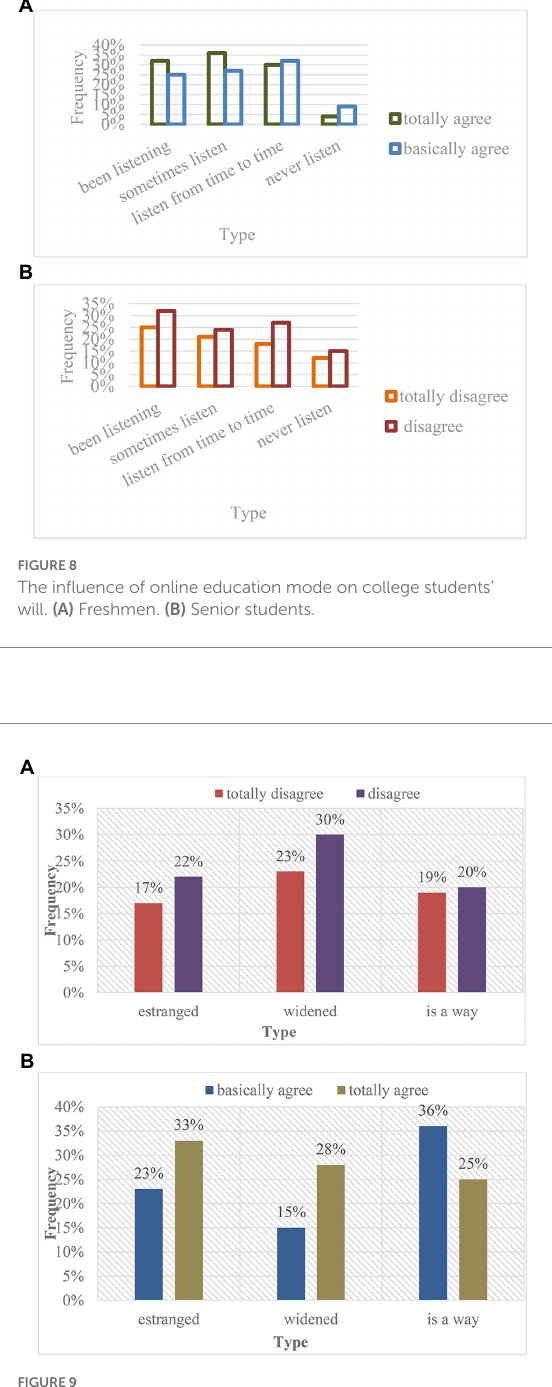
FIGURE 9 The impact of online education mode on college students’ social interaction. (A) Freshmen. (B) Senior students.